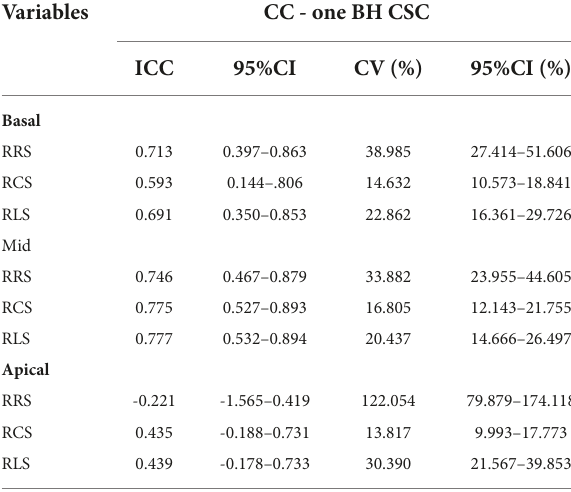
TABLE 5 Agreement of 3D left ventricular regional strain assessment between